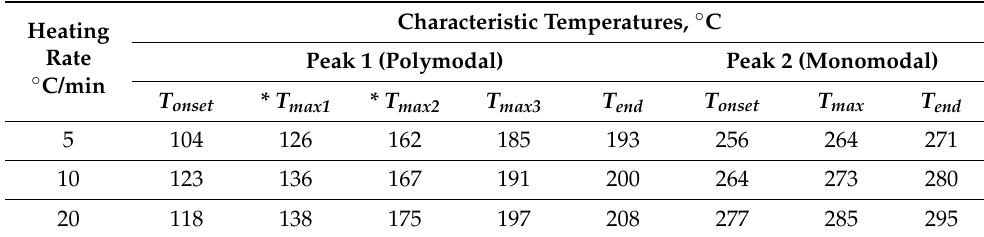
Table 4. Characteristic temperatures of the main exothermic peaks on the DSC curve corresponding to thermochemical transformations in the (Cu/a-Si) 30 multilayer films.